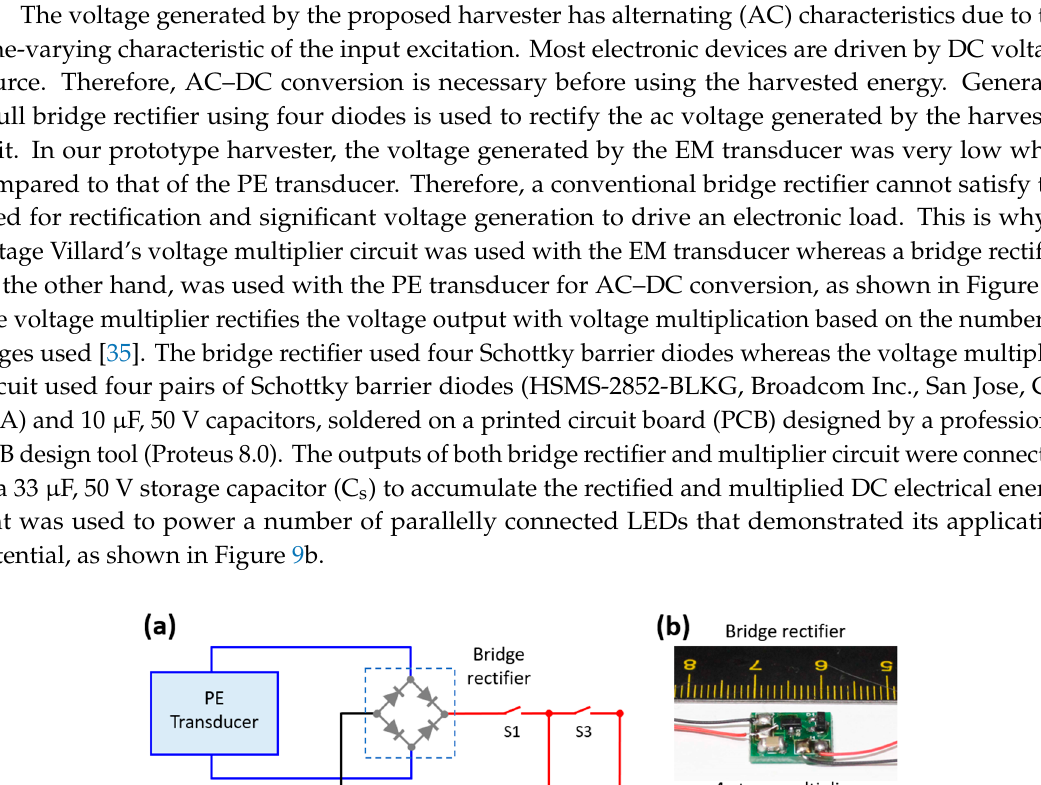
Figure 10. Voltage waveforms generated by each transducer ( a ) and accumulated rectified and multiplied voltages across the storage capacitor ( b ) as a function of time while excited by human-limb motion.